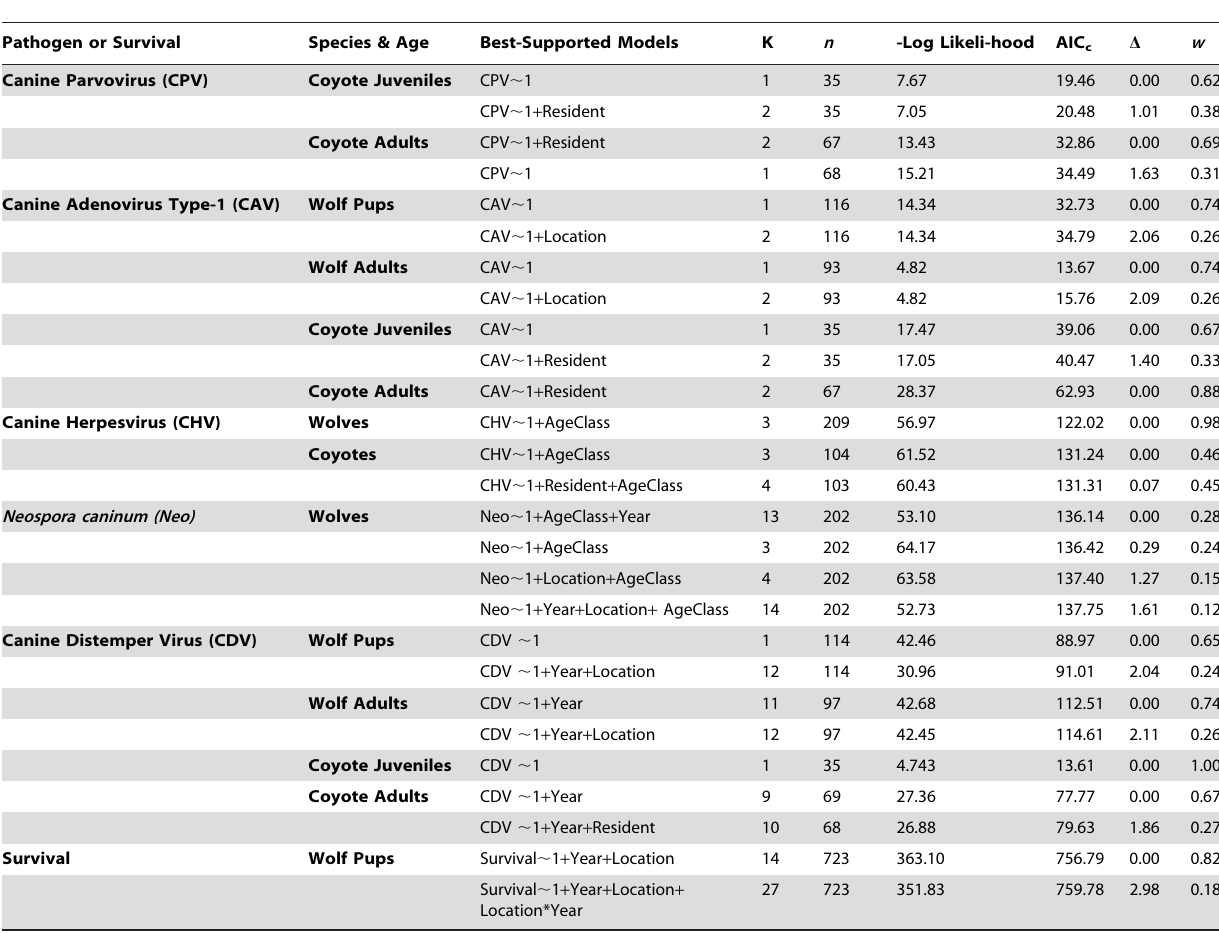
Table 4. Top models of disease seroprevalence and survival for Yellowstone National Park’s canids.